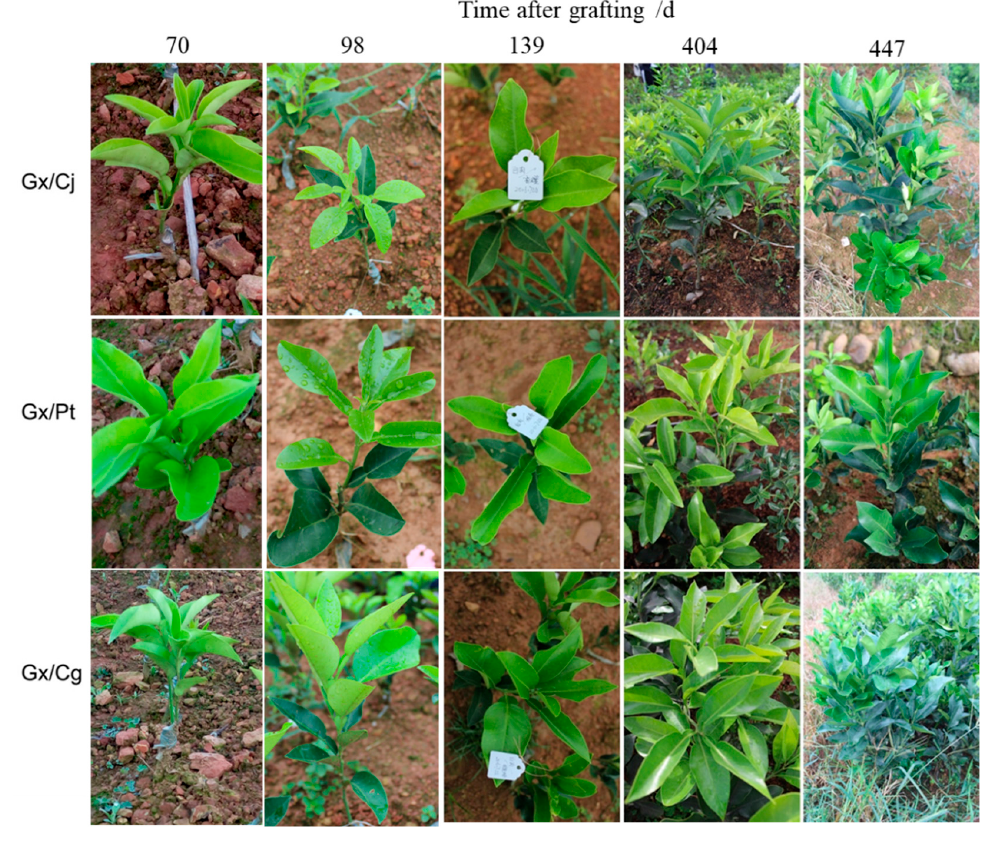
Figure 1. Field performance of ‘Guanxi Miyou’ scion grafted onto three citrus rootstocks at different stages.